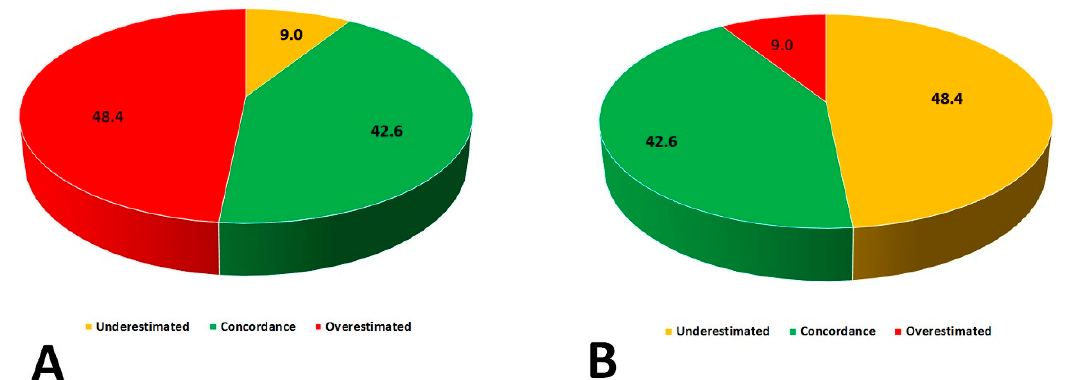
Figure 1. Differences in weight status classification based on BMI and Body Adiposity Index (BAI). ( A ) Concordance of assessing adiposity status by BAI (Reference BMI); ( B ) Concordance of assessing adiposity status by BMI (Reference BAI). Table 3. Anthropometric and body composition measurements.